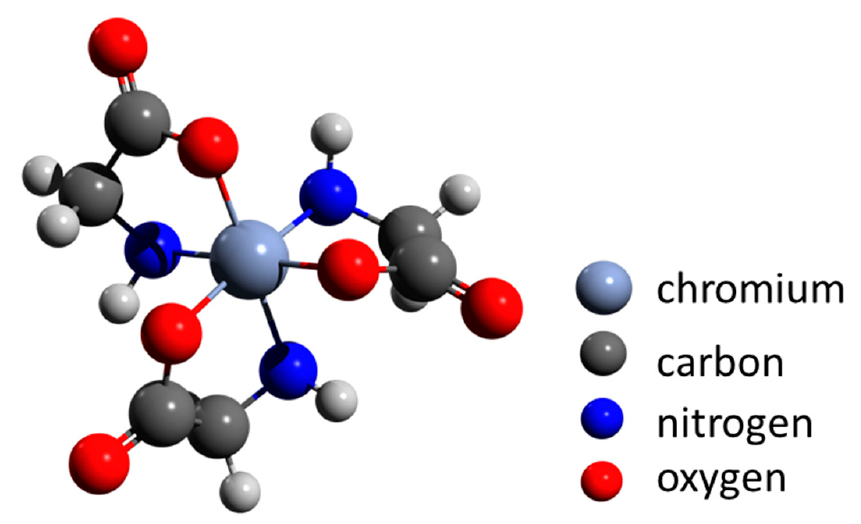
Figure 3. The chemical structure of glycine-Cr(III) as a proposed precursor for hydrothermal crystallization of α -CrOOH (grimaldiite) and β -CrOOH (guyanaite) at 250 ◦ C. Adapted from Cheng et al. [151].